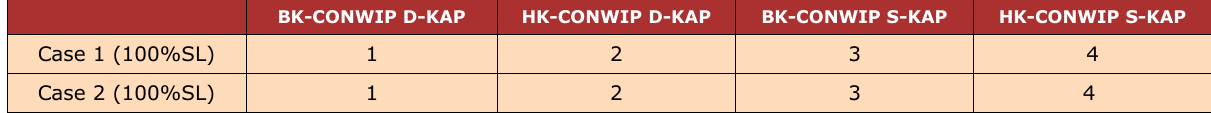
Table 19. Summary of robustness analysis ranking for Service Level (SL)